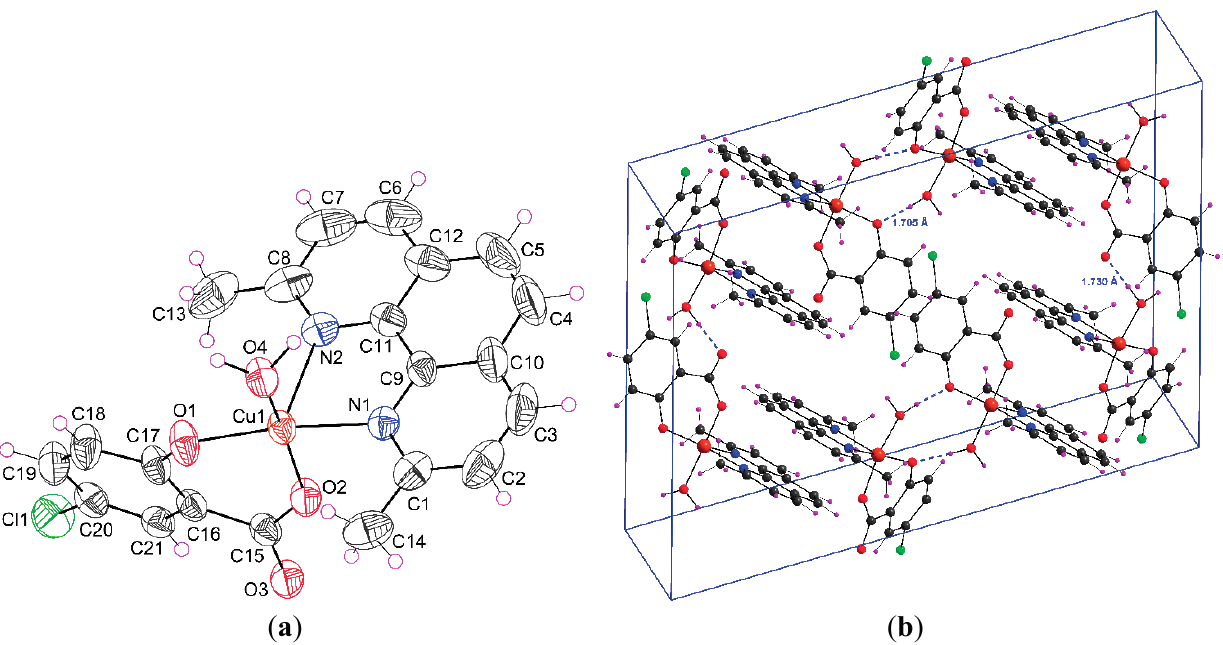
Figure 1. ( a ) Perspective view of complex 1 , with the atom numbering scheme. Thermal ellipsoids are drawn at the 50% probability level; ( b ) View of the packing of 1 in the unit cell with hydrogen bonds (dashed blue lines).